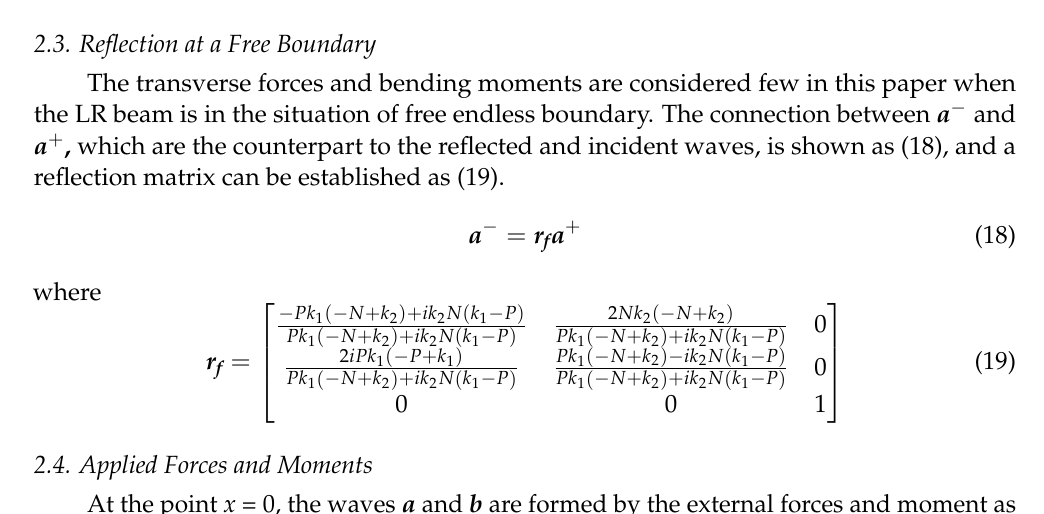
Figure 1. Wave propagation between two points of a uniform beam at a distance of x . (Reprinted from Ref. [37].)